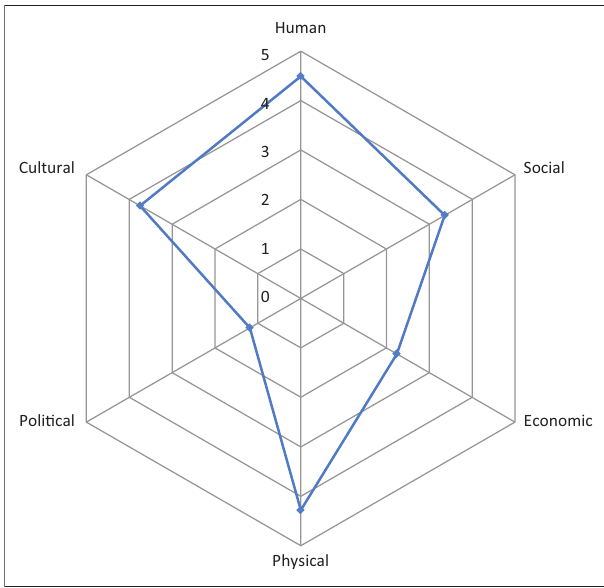
FIGURE 3: Overall ratings of